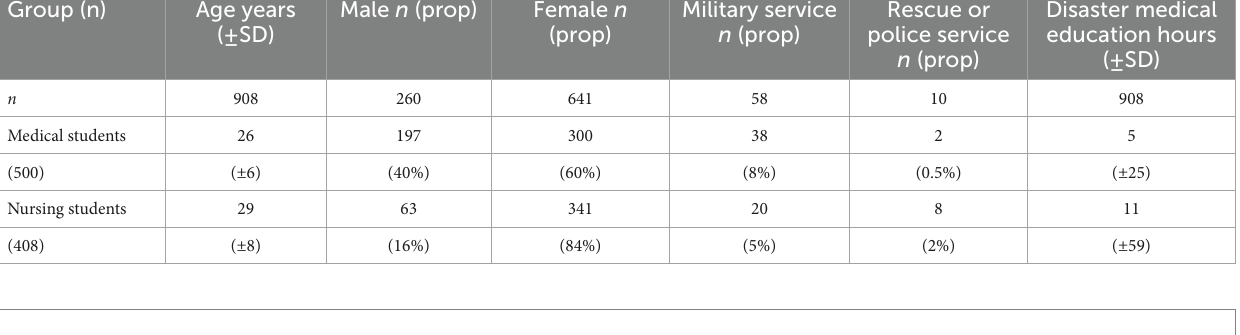
TABLE 2 Summary of the demographics of the included medical and nursing students. Group (n)